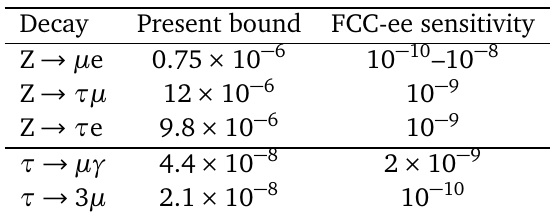
Table 5: FCC-ee sensitivities to cLFV processes in Z decays and in two benchmark τ -decay modes, compared to present bounds. The range of values for the Z → µ e mode reflects whether or not particle identification via d E / d x will be